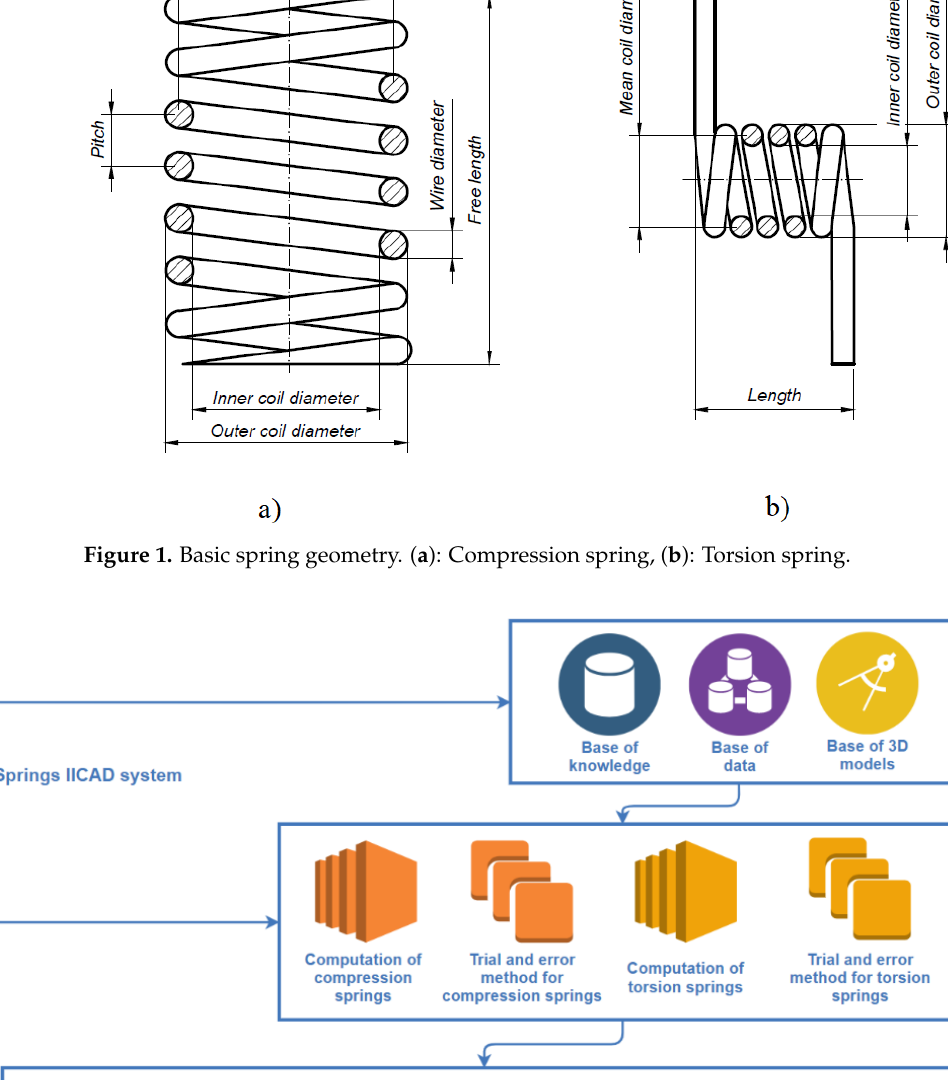
Figure 1. Basic spring geometry. ( a ): Compression spring, ( b ): Torsion spring.